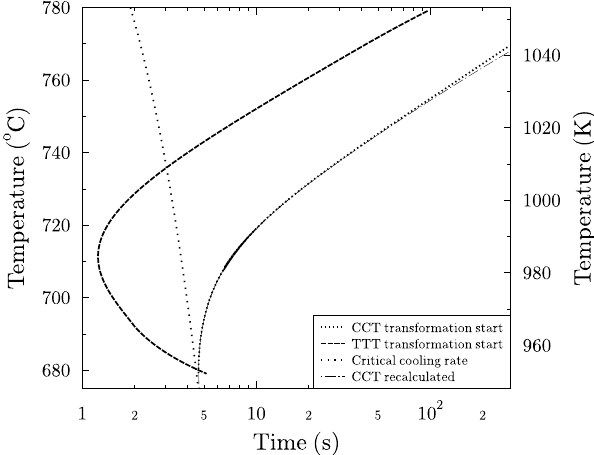
Figure 3. Ideal (or true) isothermal transformation diagram calculated with Equation (8), the original CCT diagram calculated with Equation (3), and the CCT diagram which was recalculated by applying the Scheil’s additivity principle in Equation (12).